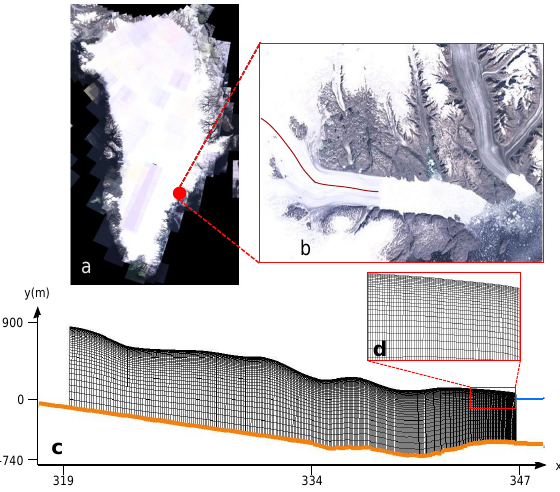
Figure 5. Glacier location and geometry. (a) Location on the Green- land ice sheet (red dot). (b) Close-up of the Helheim Glacier front and the flow line (red curve) studied here. (c) Mesh constructed for this segment of the flow line. The starting position corresponds to the front position at 347km (May 2001). The blue line indicates sea level. (d) Close-up of the upper surface of the glacier at the calving